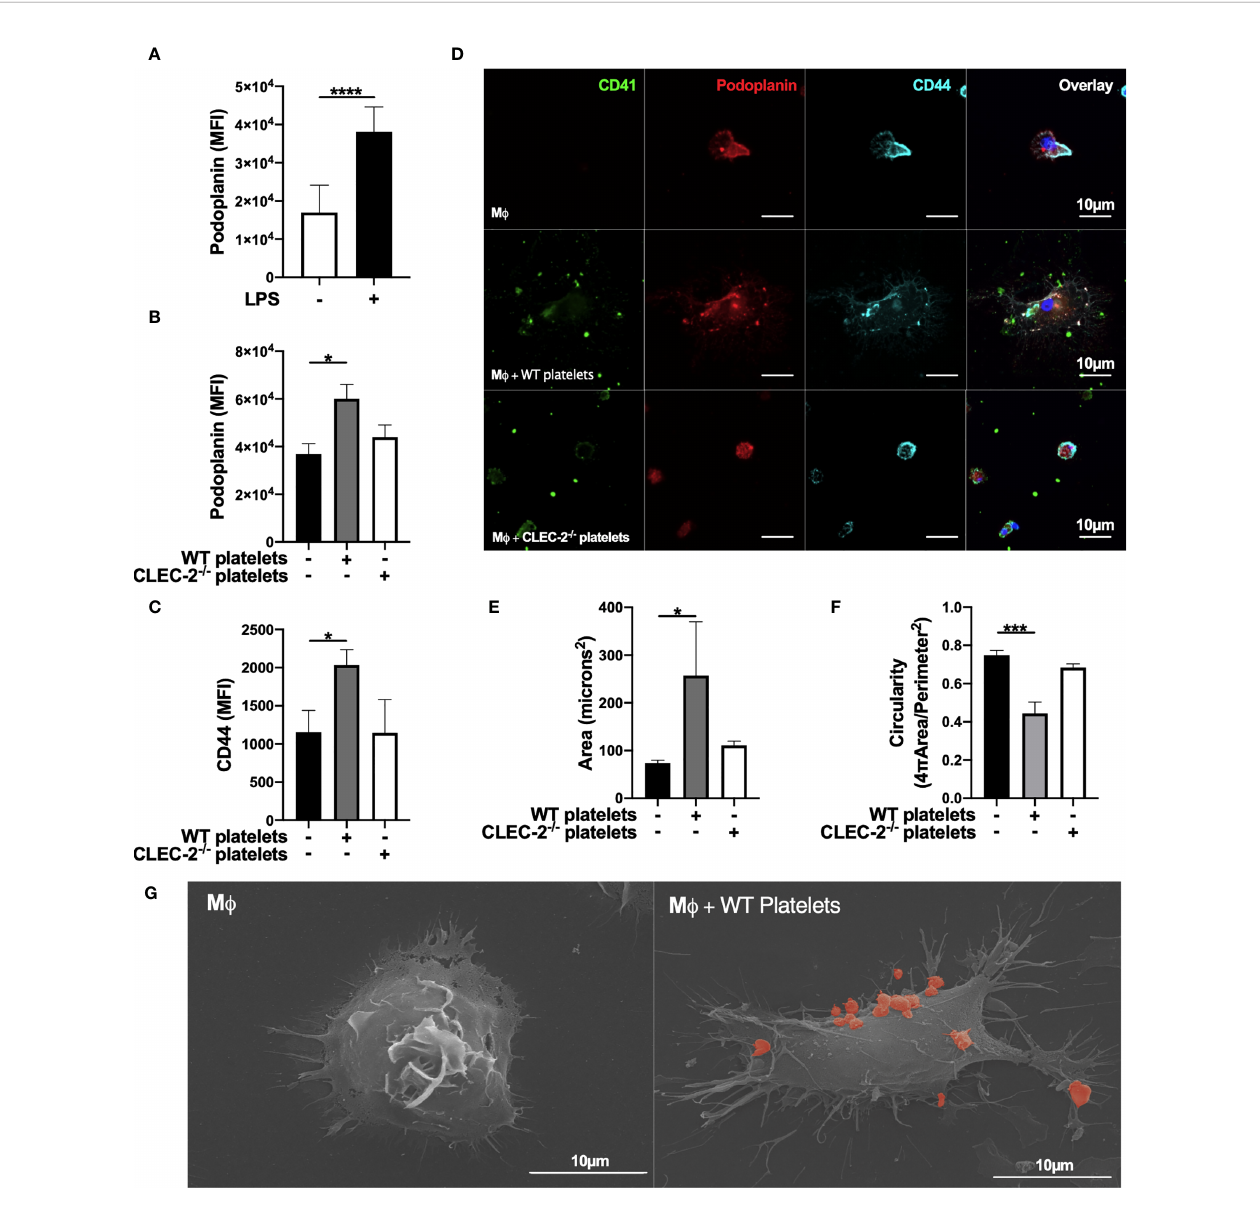
FIGURE 2 | Platelet CLEC-2 upregulates podoplanin and CD44 expression on LPS-stimulated BMDM. (A) BMDM were incubated in the presence or absence of LPS (1µg/ml) for 24h. (B, C) LPS-stimulated BMDM (M f ) were co-cultured in the absence or presence of WT or CLEC-2-de fi cient platelets (100 platelets: 1 M f ). (A – C) Median of fl uorescence intensity (MFI) of podoplanin (n=4) and CD44 (n=3) was detected by fl ow cytometry. (D) M f were cultured on glass, and WT or CLEC- 2-de fi cient platelets were added for 1h. Platelets (CD41, green), podoplanin (red) and CD44 (cyan) were detected using confocal microscopy. Images are representative of 4 independent experiments. (E) Cell area and (F) circularity were analysed using ImageJ. (G) M f were cultured on glass in the presence or absence of WT platelets (red) for 1h, before fi xing and imaging by electron microscopy. The statistical signi fi cance between 2 groups was analyzed using a student ’ s paired t- test and the statistical difference between multiple groups using one-way ANOVA with Tukey ’ s multiple comparisons test. * p <0.05, *** p < 0.001, **** p